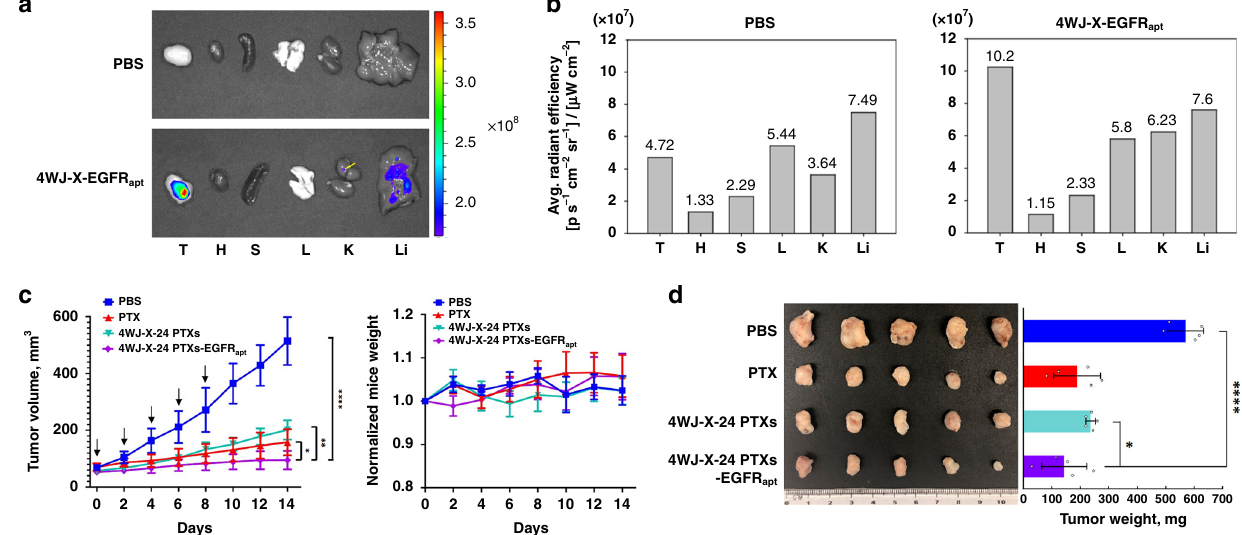
Fig. 6 In vivo biodistribution and tumor inhibition of 4WJ-X-24 PTXs nanoparticles. a Representative organ images showing speci fi c tumor targeting of Alexa Fluor 647 labeled 4WJ-X-EGFR apt nanoparticles 8 h post-injection into mice bearing MDA-MB-231 xenograft (T: tumor, H: heart, S: spleen, L: lung, K: kidney, and Li: liver; Color scale: radiant ef fi ciency, [p s − 1 cm − 2 sr − 1 ] [ μ W cm − 2 ] − 1 ). Very low radiant mark was revealed in the liver of 4WJ-X-EGFR apt treated sample. b Quantitative analysis of biodistribution in tumors and normal organs, quanti fi ed from the organ images. c Intravenous treatment of nude mice bearing orthotopic MDA-MB-231 xenografts with 4WJ-X-24 PTXs-EGFR apt nanoparticles (purple) and control groups (turquoise: 4WJ-X-24 PTXs, red: PTX, blue: PBS) every other day for a total of fi ve injections (8 mg kg − 1 , PTX per body weight, indicated by arrows). Mice body weight was monitored during the time course of treatments ( n = 5 biologically independent animals, statistics was calculated by two-tailed unpaired t -test presented as mean ± respectively). d Representative images of breast cancer tumors harvested from mice after treatments ( n = 5 biologically independent animals, statistics